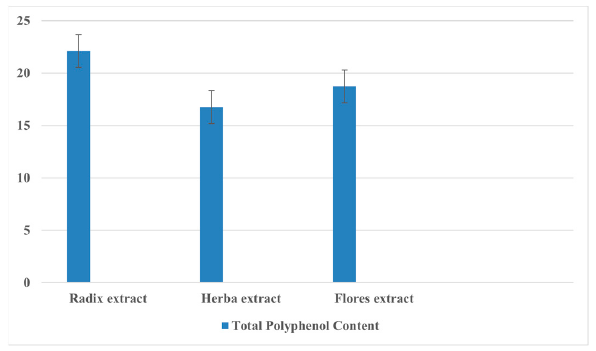
Figure 2. Total polyphenol content in the extracts with ethanol 50% ( v/v ) from Lysimachia nummularia L.